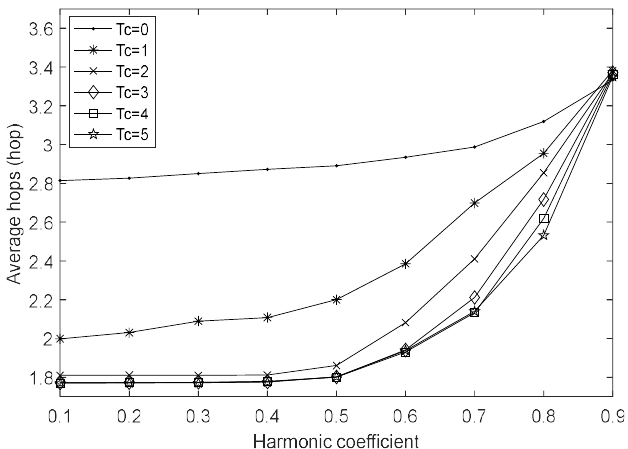
Sensors 2018 , 18 , x FOR PEER REVIEW Figure 6. Average hops with varying harmonic coefficient. Figure 6. Average hops with varying harmonic coefficient.